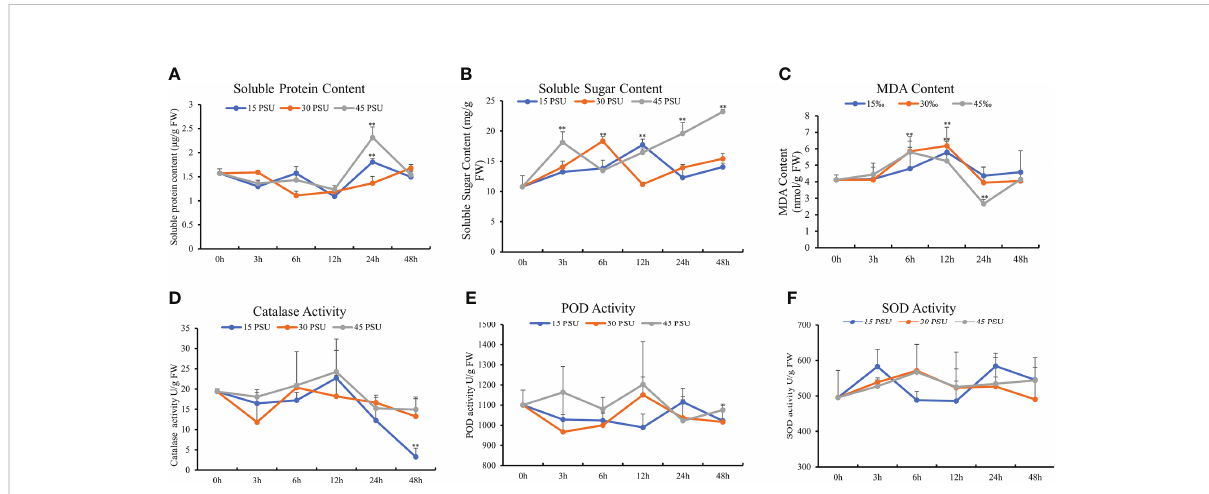
FIGURE 4 Physiological and biochemical index changes under different salinity conditions. (A) Soluble protein content; (B) soluble sugar content; (C) malondialdehyde (MDA) content; (D) catalase activity; (E) peroxidase (POD) activity; (F) superoxide dismutase (SOD) activity. The statistical signi fi cance was assessed using Student ’ s t multiple comparisons test. ** P <0.01.